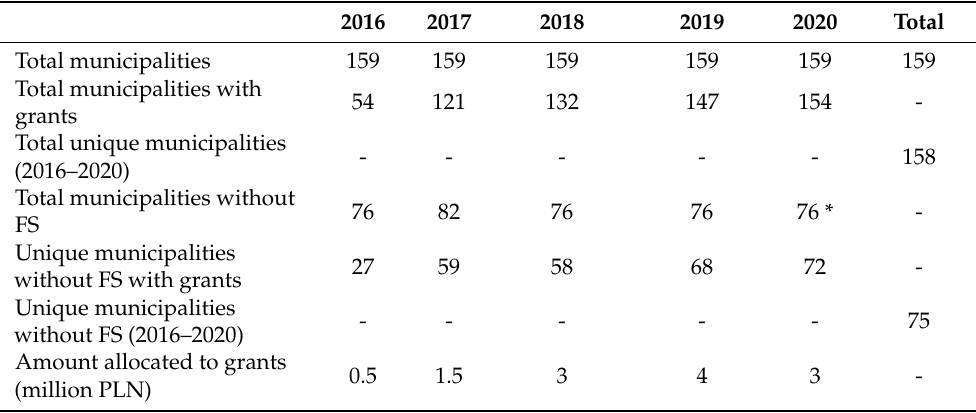
Table 4. Structure of the communes in the areas from which the programme beneficiaries originate, considering the presence of a Sołecki Fund in the municipalities.